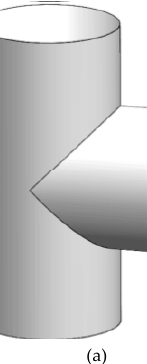
Figure 2. The three-way tube is one of models in our experiments. ( a ) is the CAD model of the three-way tube, and ( b ) is the point cloud model of the three-way tube after sampling.